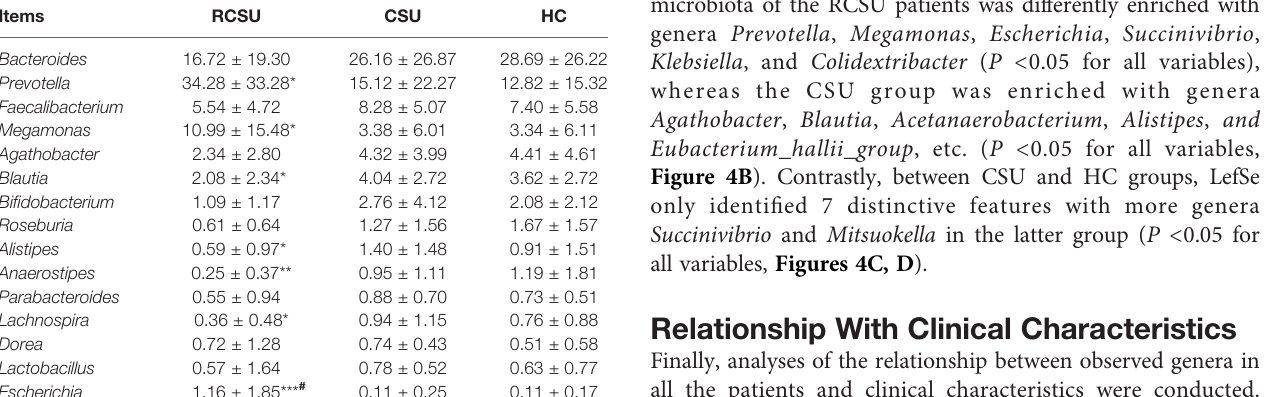
TABLE 3 | Relative abundance of genera bacterium among the three groups. Items